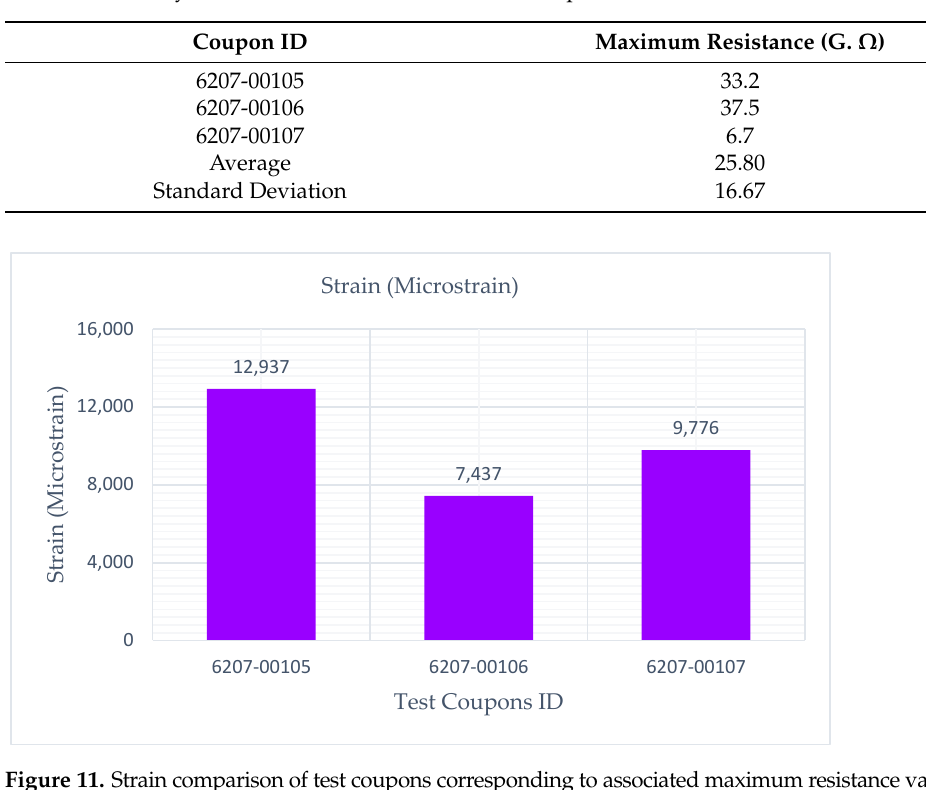
Table 3. Summary of the maximum resistance of test coupons.